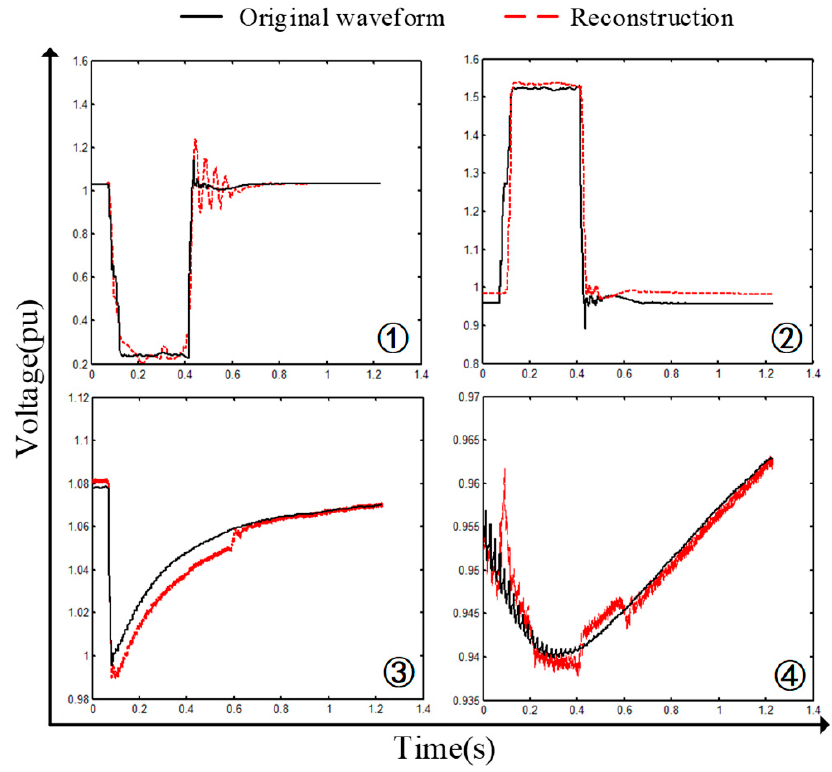
Figure 8. Reconstruction of the sag waveform.